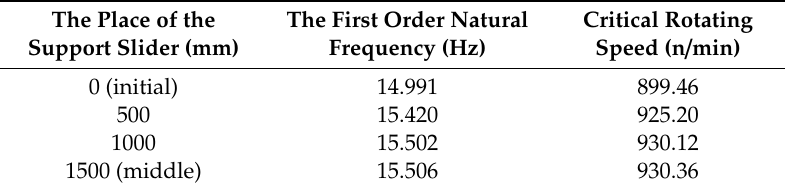
Table 2. The different first-order natural frequencies of the lead screw with the support slider and corresponding critical rotating speed.